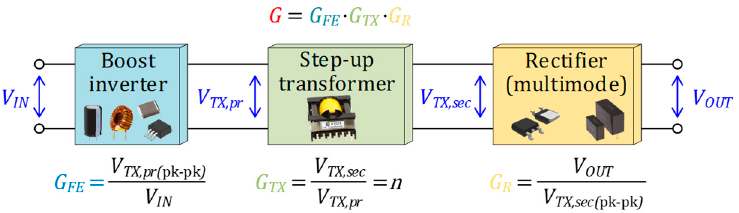
Figure 1. A generalized representation of a wide input voltage range galvanically isolated high step-up DC-DC converter.